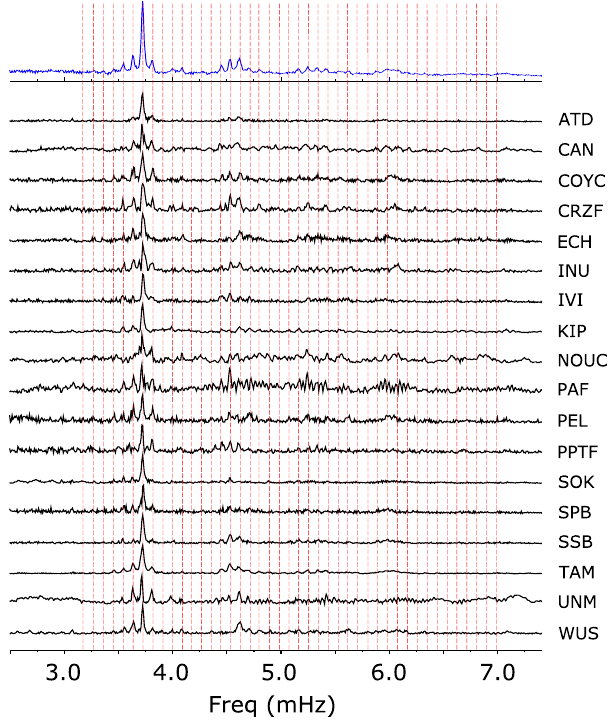
Fig. 6 Normalized amplitude spectra for a selection of seismic stations. The spectra has been calculated for the 24 hours of the day of the eruption using stations of the Geoscope network distributed throughout the world. Blue line shows the spectra stack of the 95 traces analyzed. Red dashed lines show the eigenfrequencies for the PREM